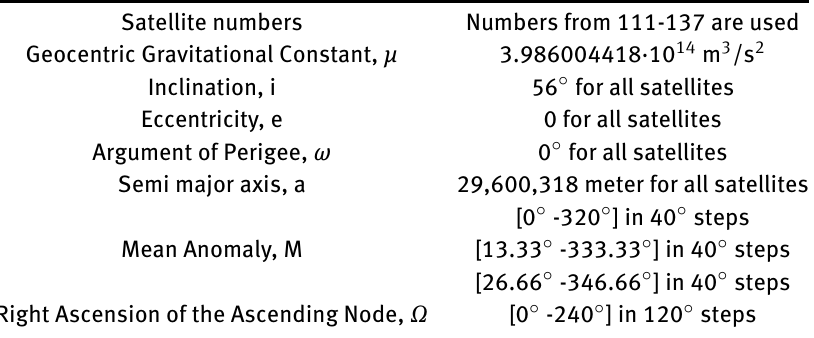
Table 1: The Galileo orbit parameters